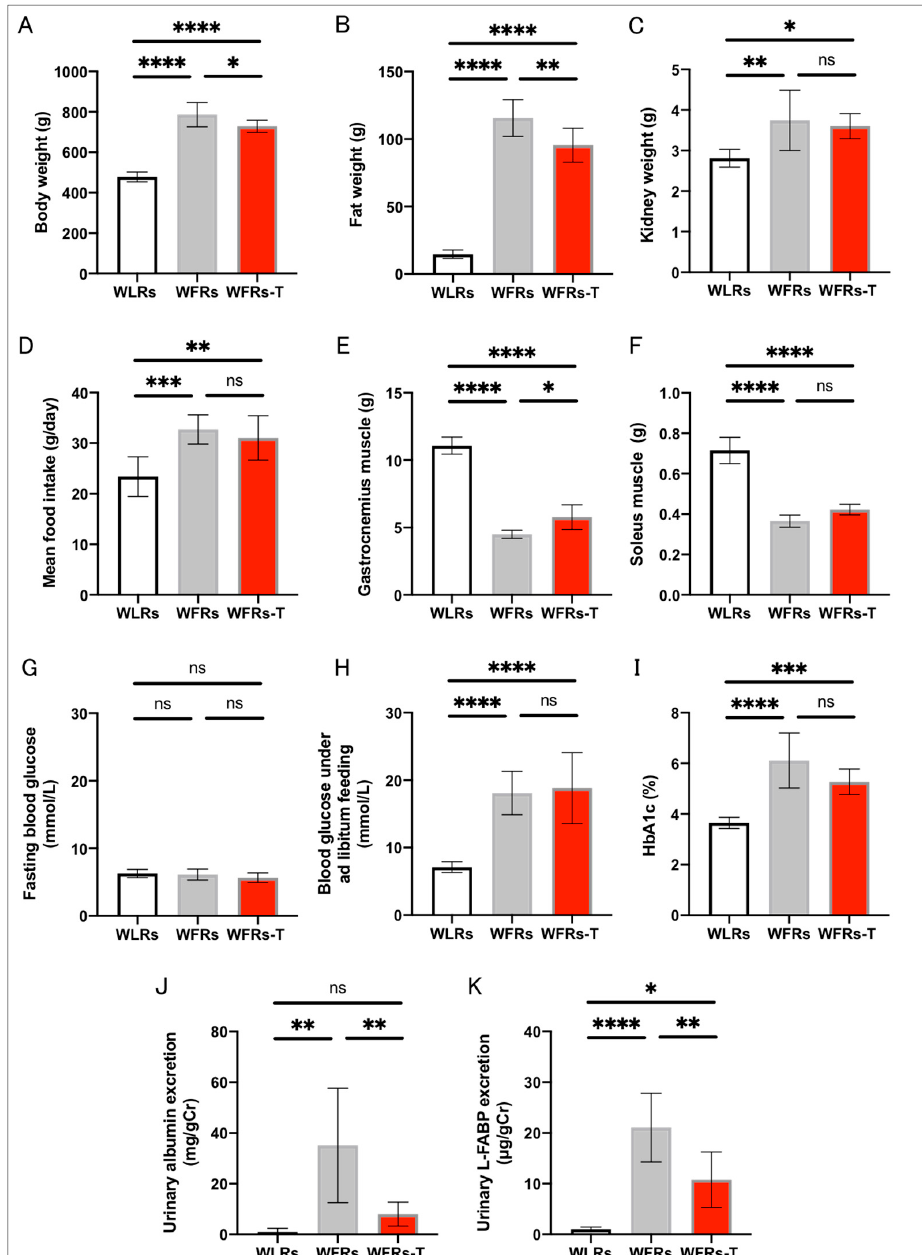
Figure 1. Characteristics of rats at 44 weeks of age: ( A ) whole-body weight; ( B ) fat weight; ( C ) kidney weight; ( D ) mean food intake; ( E ) gastrocnemius muscle weight; ( F ) soleus muscle weight; ( G ) fasting blood glucose; ( H ) blood glucose under ad libitum feeding; ( I ) HbA1c levels (WLRs: n = 8, WFRs: n = 8, WFRs-T: n = 7); ( J ) urinary albumin/creatinine (Cr) ratio; and ( K ) liver-type fatty-acid-binding protein (L-FABP)/Cr, at 44 weeks of age ( n = 6, respectively). All data are means ± standard deviation (SD). * p < 0.05, ** p < 0.01, *** p < 0.001, **** p < 0.0001, ns: not significant. WLRs, sedentary Wistar lean rats; WFRs, sedentary Wistar fatty rats; WFRs-T, Wistar fatty rats with treadmill exercise